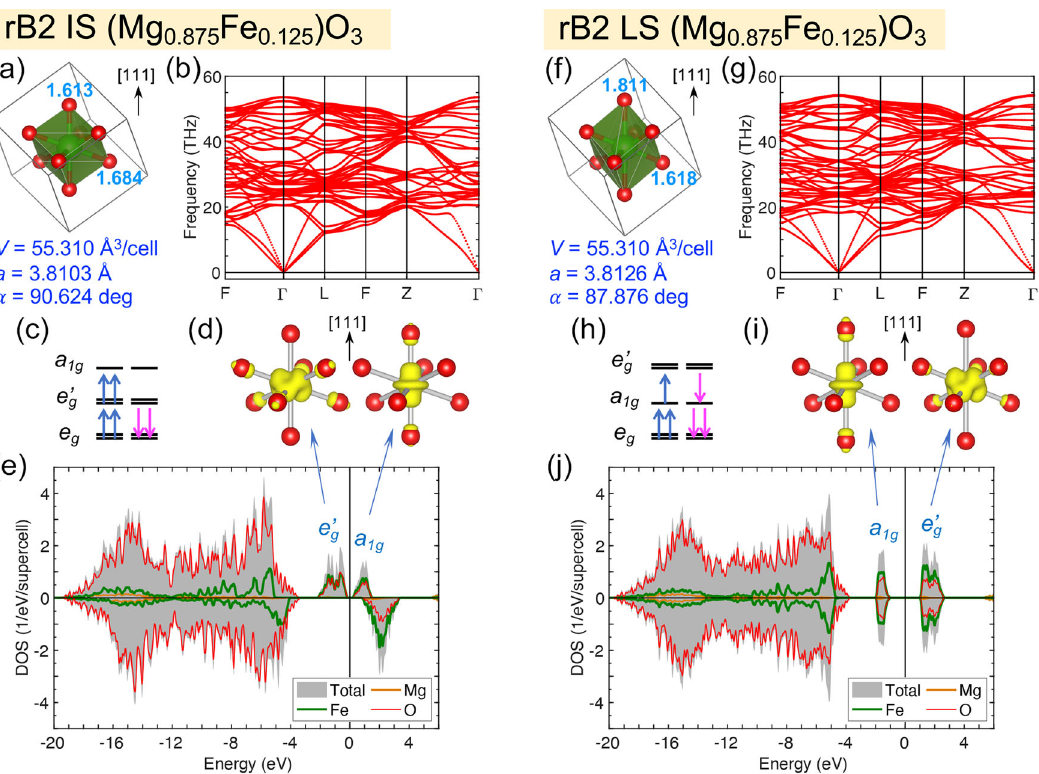
Fig. 4 Atomic structure, stability, and electronic structure of rhombohedrally distorted rB2 (Mg 0.875 Fe 0.125 )O. Here, the intermediate-spin (IS, a – e ) and low-spin (LS, f – j ) states at volume V = 55.310 Å 3 /cell (6.914 Å 3 /f.u., pressure P ≈ 1.07 TPa) are shown. a , f FeO 8 dodecahedra in the supercell, with the Fe-O bond lengths (in Å ) indicated by the numbers next to the oxygen atoms, and the lattice parameters ( a and α ) listed below; b , g phonon dispersion; c , h orbital occupation; d , i integrated local density of states (ILDOS) of the e 0 and a 1 g bands; e , j total and projected DOS, with the Fermi level set as the reference (0 eV). In panels a , d , f , and ( i ), the [111] direction is pointing